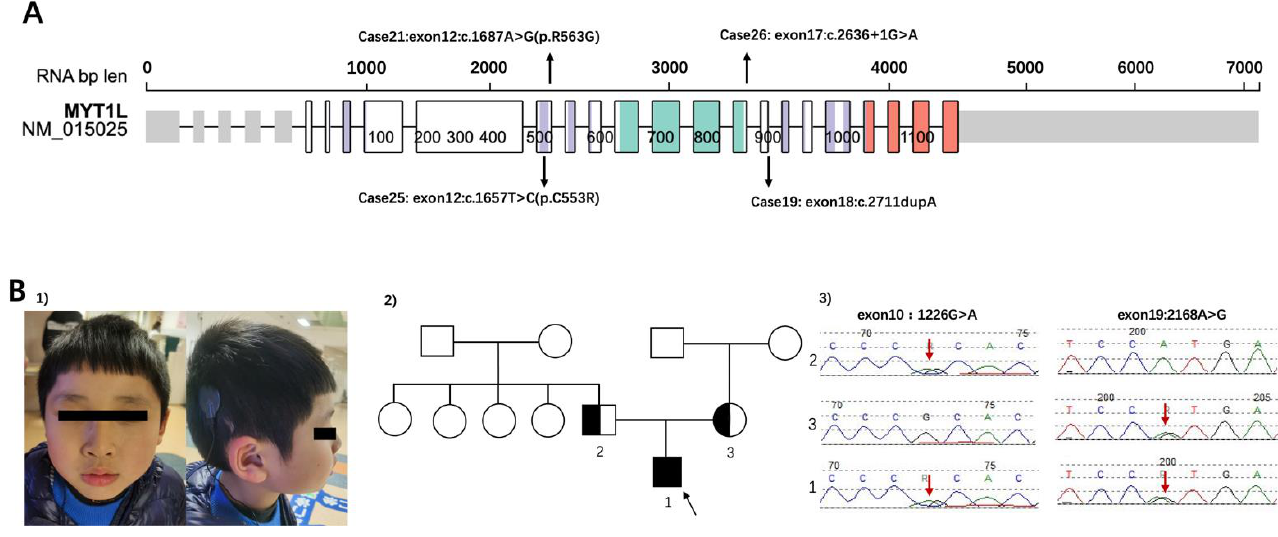
Figure 3. ( A ) The locations of variants of patients in the study. Representation based on Protein Paint (Wisteria color: zf-C2HC domain, Turquoise color: MYT1 domain, Orange color: Smc domain) (https://proteinpaint.stjude.org/, accessed on 1 March 2022). The cases correspond with Table 1. ( B ) (1) The dysmorphic features of case 6 (shown for 1). (2) The Pedigree of family 1. 2 was the father of the patient; 3 was the mother of the patient. The black arrow showed the patient of case 6. (3) SLC26A4 sequence results of patient and his parents. Heterozygous variants of SLC26A4 were identified in the proband (red arrows in patient 1). Both his parents were in a heterozygous state for the variant (paternal: red arrow of 2 for c.1226G>A (p. R409H) in exon 10, maternal: red arrow of 3 for